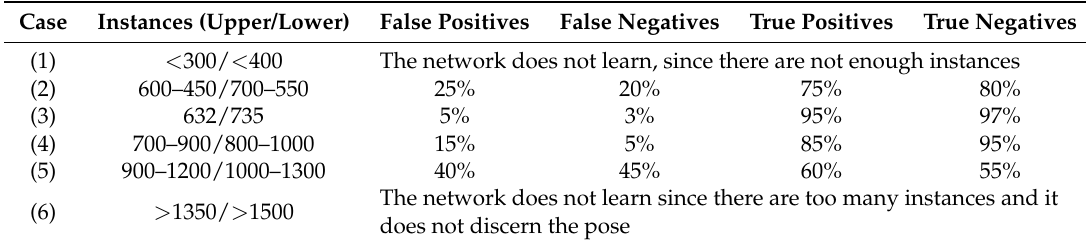
Table 3. Different number of instances in the learning set.